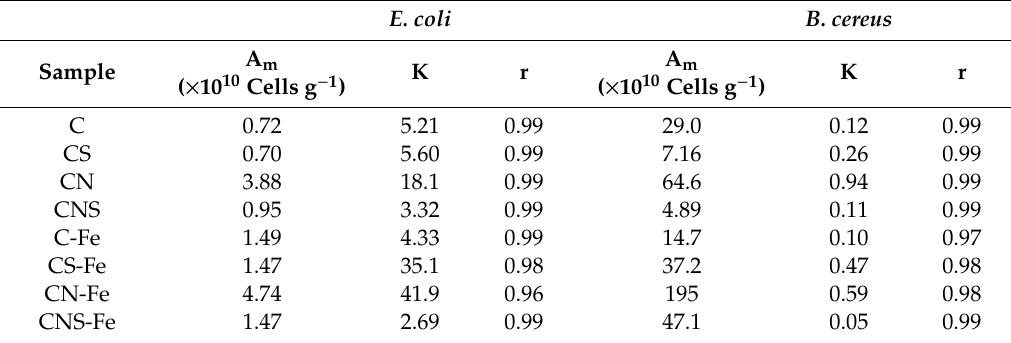
Table 2. The Langmuir isotherm parameters based on the adsorption of the bacteria on the doped